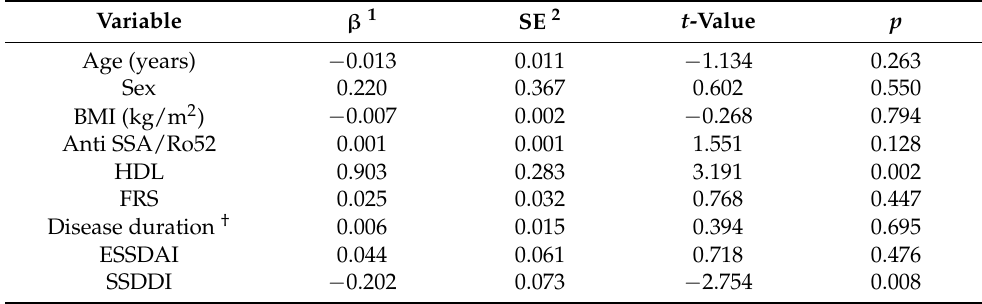
Table 5. Multiple Linear Regression model of independent predictors for serum adropin